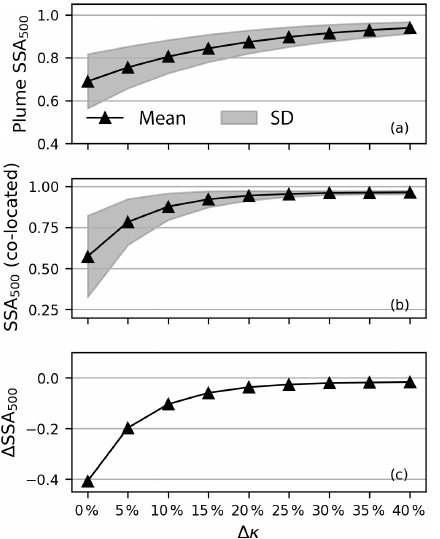
Figure 3. SSA retrieved by radiative transfer simulations as a func- tion of (cid:49)κ ( (cid:49)κ = (κ 354 − κ 388 )/κ 388 ): (a) SSA mean and standard deviation (filled region) of plume pixels; (b) SSA mean and stan- dard deviation (filled region) of the 15 AERONET-co-located pix- els; (c) absolute difference between the mean SSA of the 15 co- located pixels and the AERONET